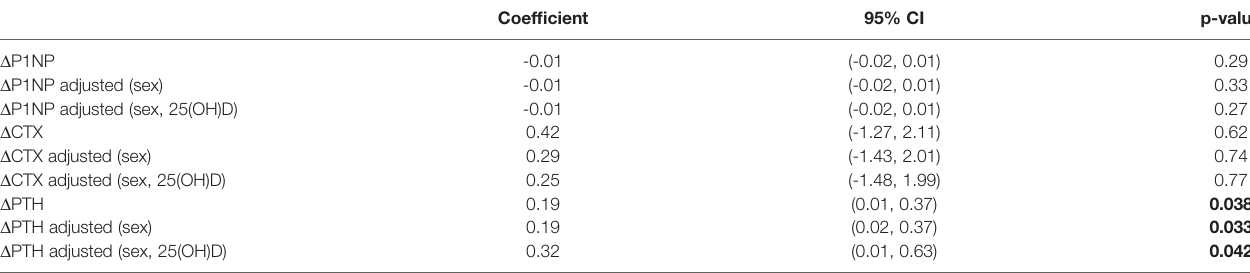
TABLE 3 | Multiple linear regression analysis of change in insulin resistance by HOMA-IR and change in bone